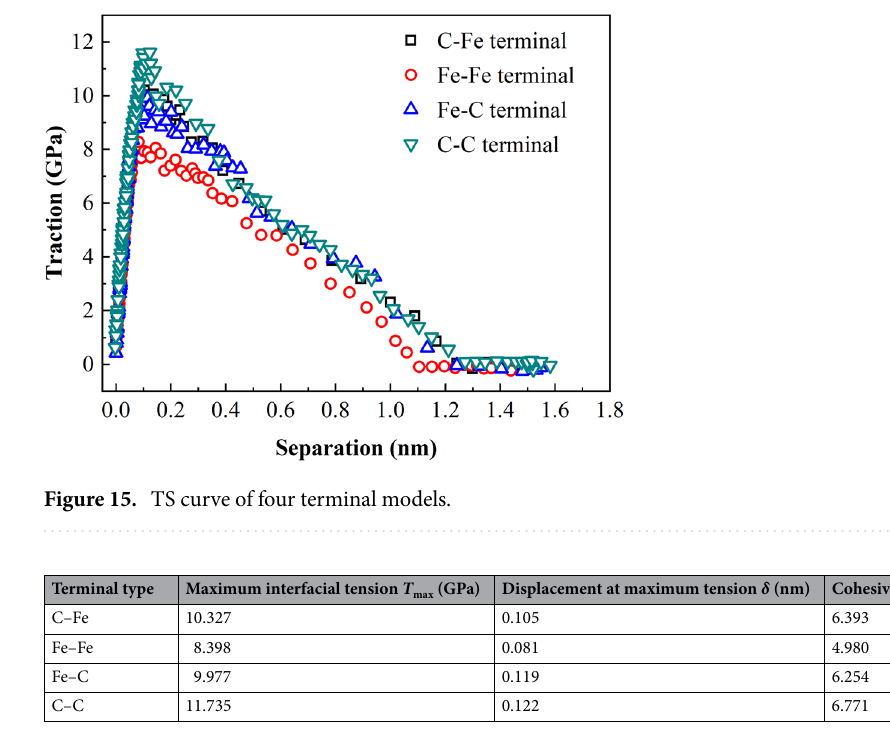
Table 7. Cohesion model parameters of four terminal models.